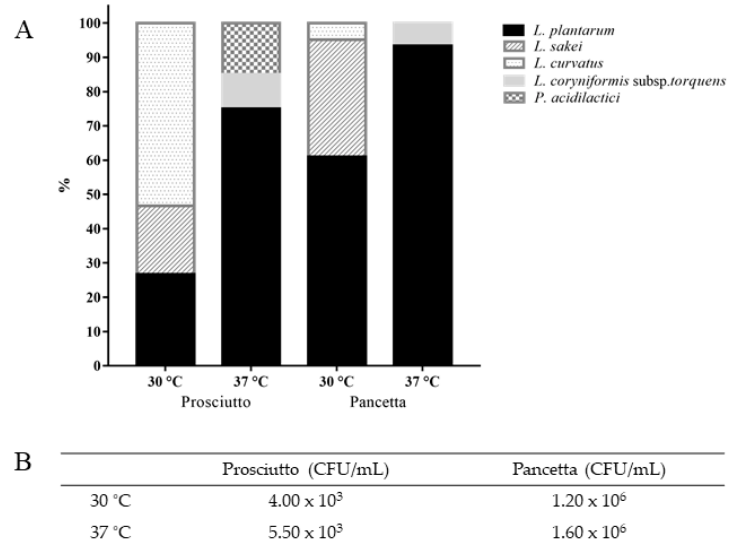
Figure 1. ( A ) LAB species populations identified based on 16S rRNA gene sequence analysis. A total of 35 isolates ( n = 15 at 30 °C and n = 20 at 37 °C) from prosciutto and 71 isolates ( n = 41 at 30 °C and n = 30 at 37 °C) were selected from pancetta. ( B ) Bacterial counts (CFU/mL) on MRS agar after 48 h incubation at 30 °C and 37 °C incubation from prosciutto and